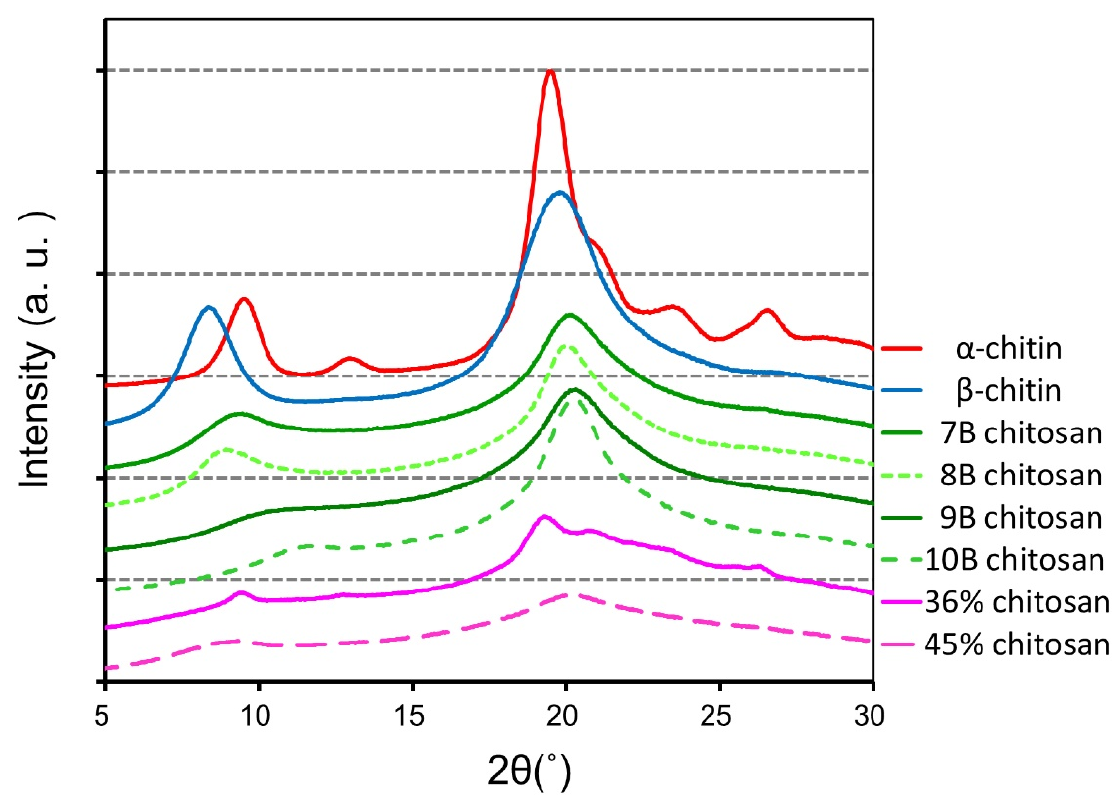
Figure 2. Observed X-ray diffraction patterns of block-type and random-type chitosan as well as α -and β -chitin substrates. The phase compositions of chitin and chitosan substrates were recorded at room temperature by X-ray diffraction.